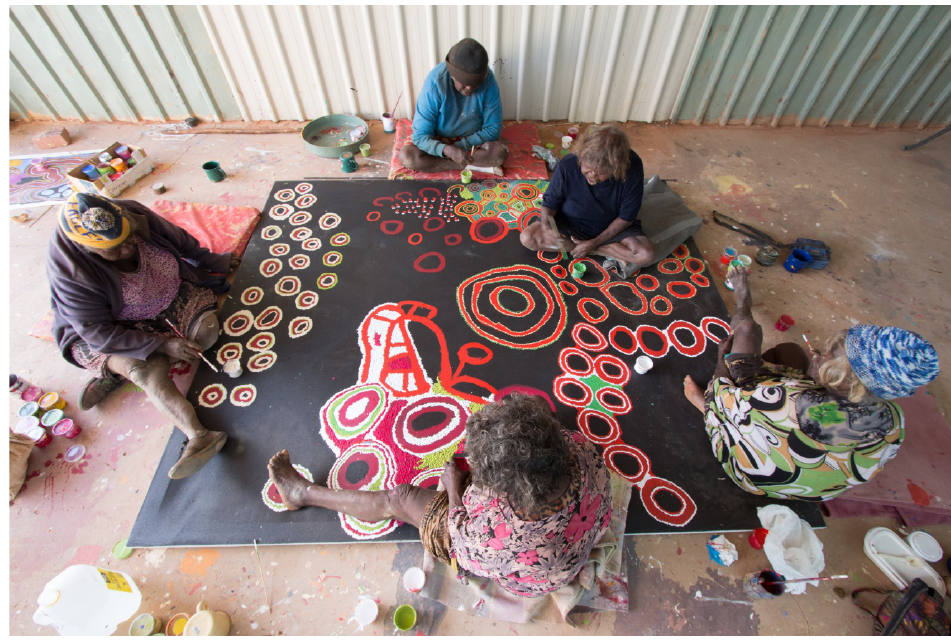
Spinifex Arts Project members Kunmanara (Anne Ngantiri) Hogan, Tjaruwa Woods, Yarangka Thomas, Ngalpingka Simms, and Myrtle Pennington painting the womens’ collective canvas Kungkarangkalpa , featured in the 2015 British Museum exhibition Indigenous Australia: Enduring Civilization. (photo: courtesy of the Spinifex Arts Project and Redot